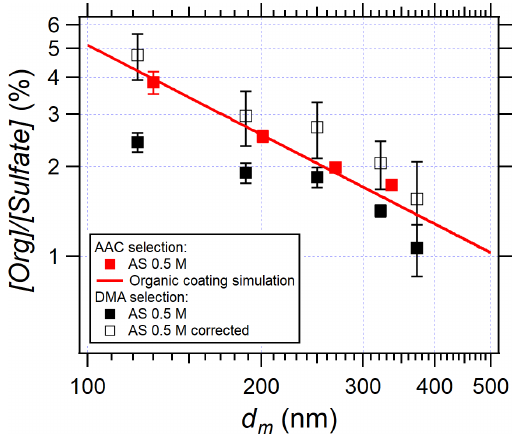
Figure 5. Influence of instrumental conditions and instrument inter- comparison: AAC selection (red squares, EXP P1), DMA selec- tion (black squares, EXP P6), and multi-charging correction (white squares). The red line represents the calculation simulating organic coated compounds at the AS particle surface using Eq. (3) with a surface density of 1.1 × 10 − 3 gm − 2 (selected from Fig. 4).